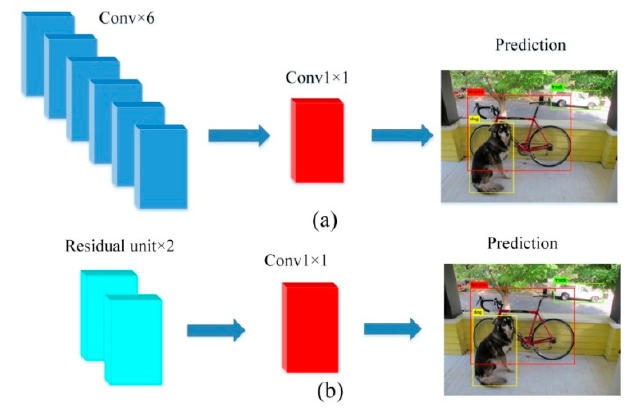
Figure 6. Outputstructure of each network. ( a ) YOLO V3; ( b ) Improved YOLO V3.